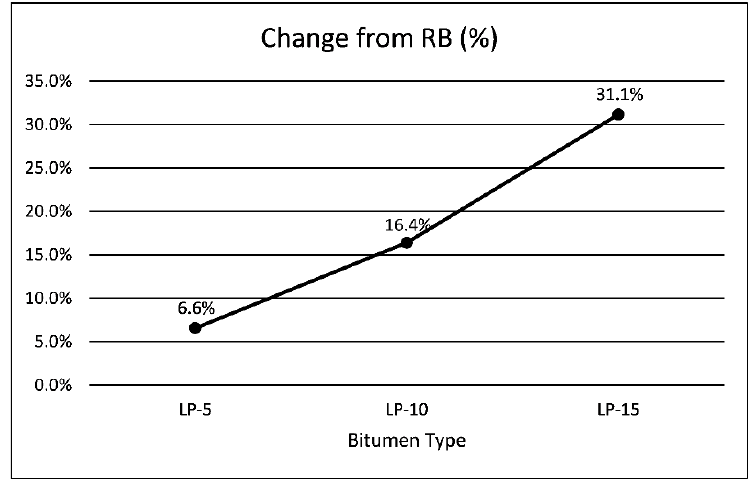
Figure 11. Change in penetration with respect to reference bitumen .